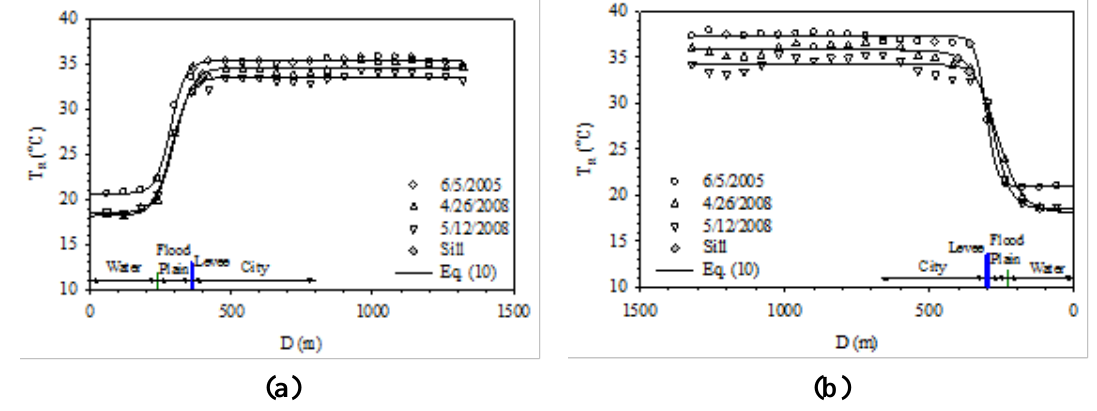
Figure 8. Surface temperature variation profiles of right bank ( a ) and left bank ( b ) at Taipei Bridge and Chong-Xiao Bridge.